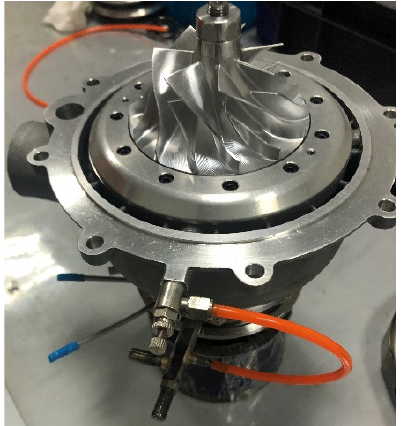
Figure 3. An example of a coaxial-rotor unit.